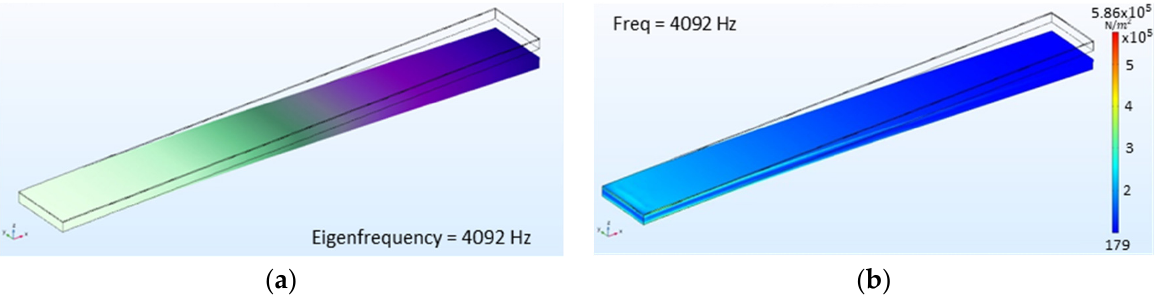
Figure 4. Linear Beam with 6.5 mm length and 800 µm width FEM simulations results: ( a ) first eigenmode with a frequency around 4092 Hz. ( b ) Stress values with a max. value 5.86 × 10 5 N/m 2 .